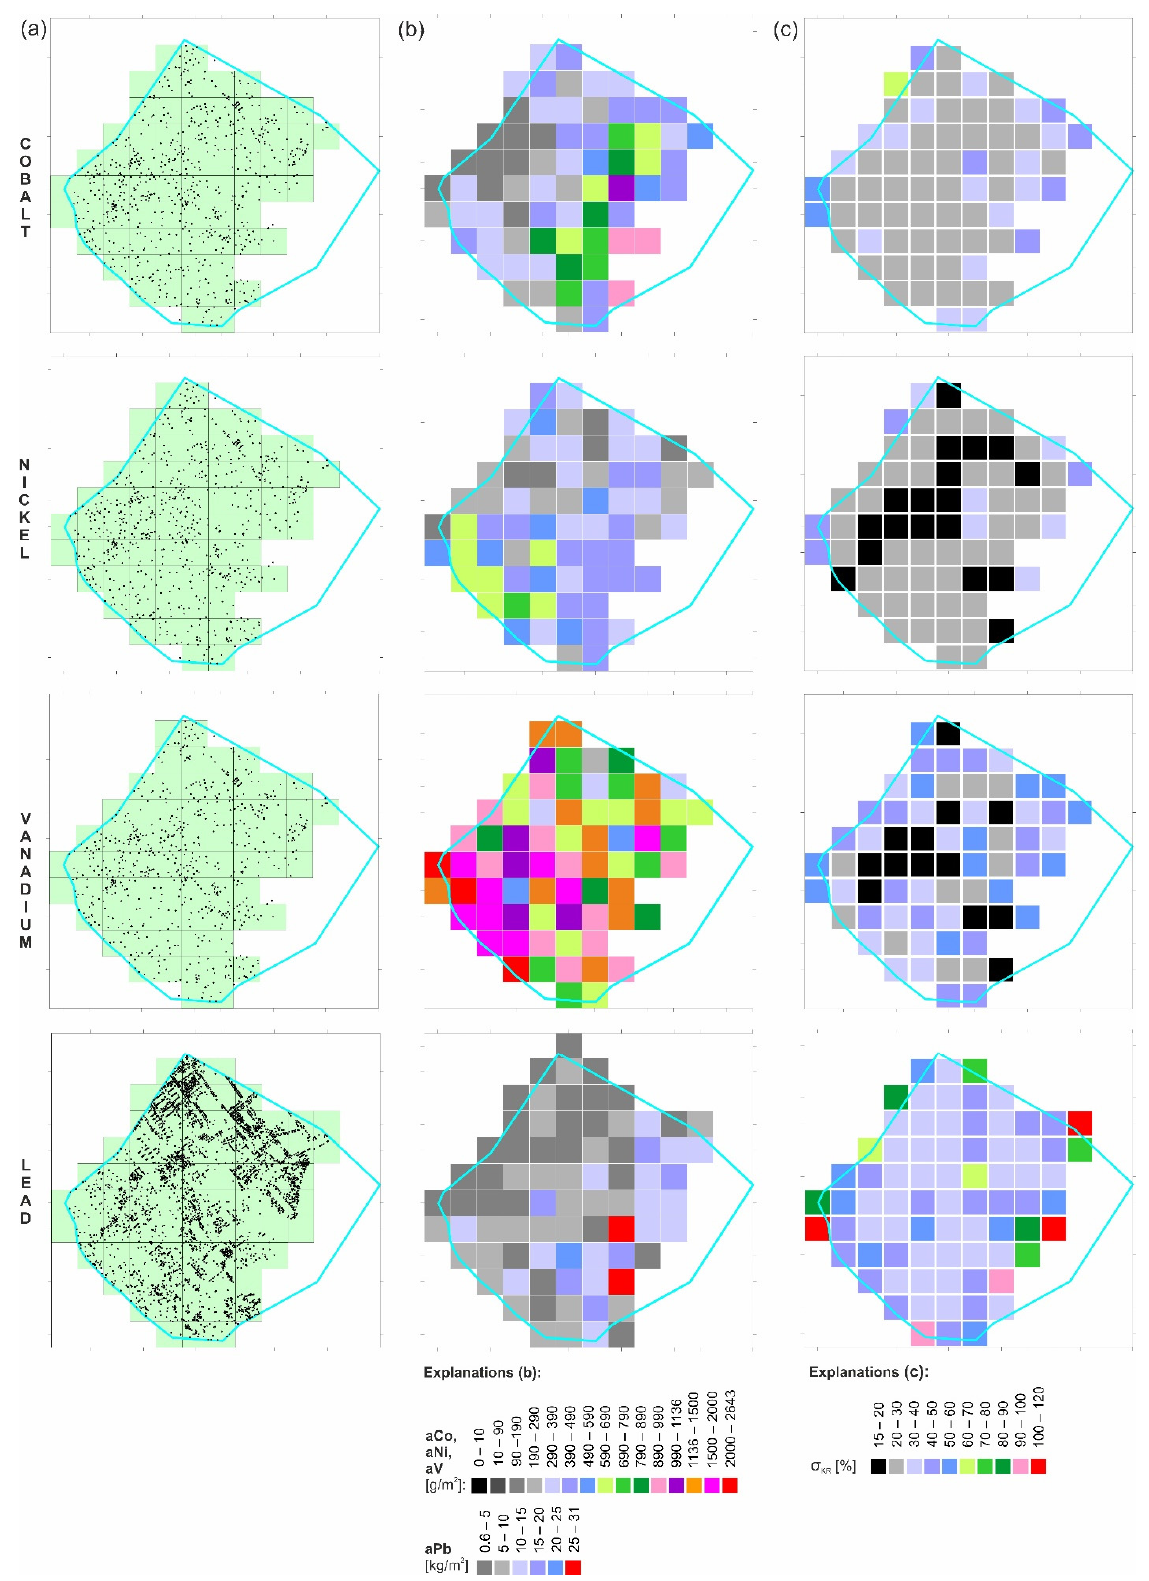
Figure 14. Location of the Co, Ni, V, and Pb sampling points in the Rudna deposit and division into calculation blocks (1 km x 1 km), where the estimates were made ( a ). The summary of the estimated mean abundance of Co, Ni, V, and Pb (aCo, aNi, aV, and aPb) ( b ) and relative standard kriging errors ( σ KR ) ( c ).